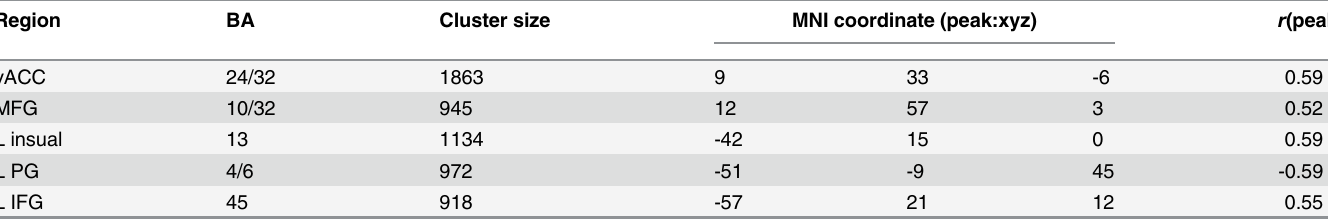
Table 1. Brain regions which exhibit significant correlations between ReHo and Stroop